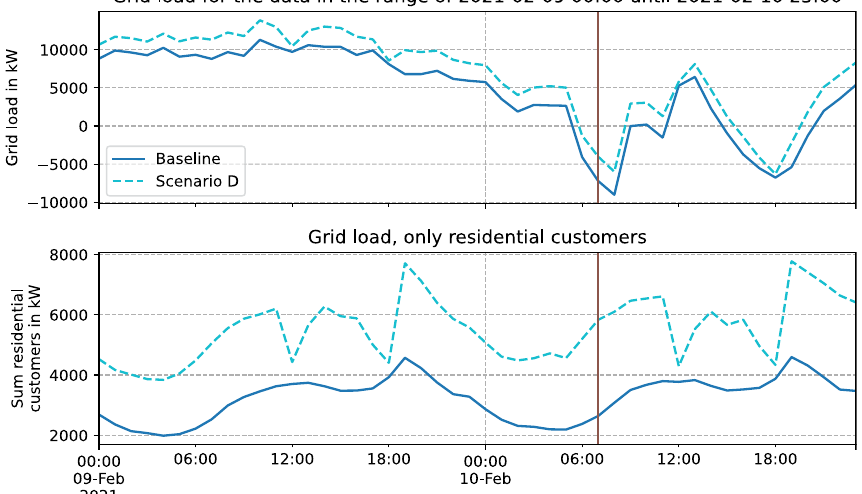
Fig. 12 Effect of the heat pumps (Scenario D) on grid load for two exemplary days in winter of 2021. The vertical line is placed at 9 th February 2021, 07:00. Top: Gird load in hourly resolution. Bottom: Grid load without wind farms and large enterprises, i.e. only residential